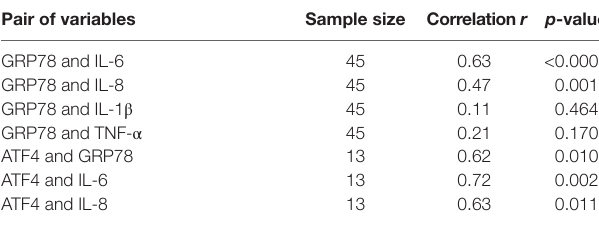
TaBle 4 | The expression of GRP78 is positively correlated with IL-6 and IL-8, but not with IL-1 β and TNF- α . The expression of ATF4 is positively correlated with GRP78, IL-6, and IL-8 (calculated by Spearman correlation